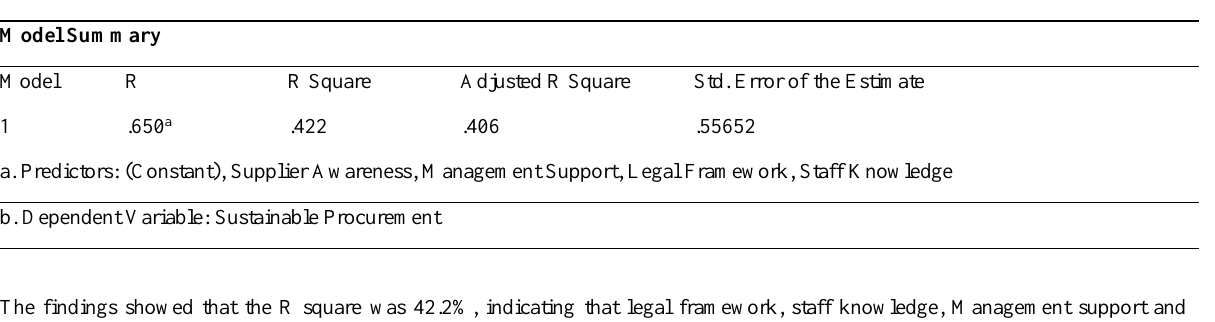
Table 10: Model summary